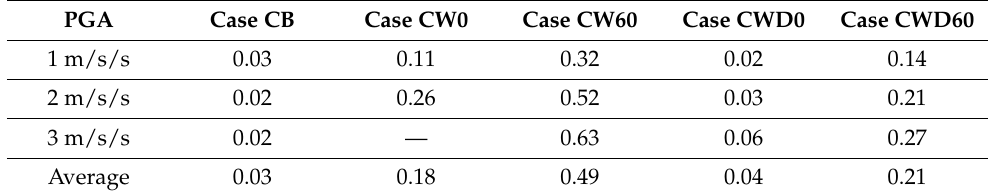
Figure 17. Displacement response of the SCS surface under simulated wave: ( a ) Maximum displace- ment for different PGAs; ( b ) displacement time histories under PGA 2 m/s/s. Table 3. The response ratio of maximum displacement to the Case C under major PGAs.